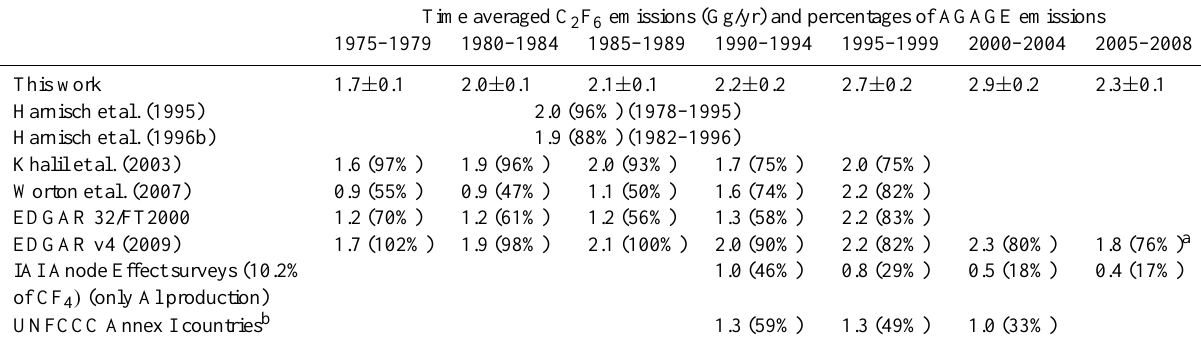
Table 7. Time averaged global C 2 F 6 emission